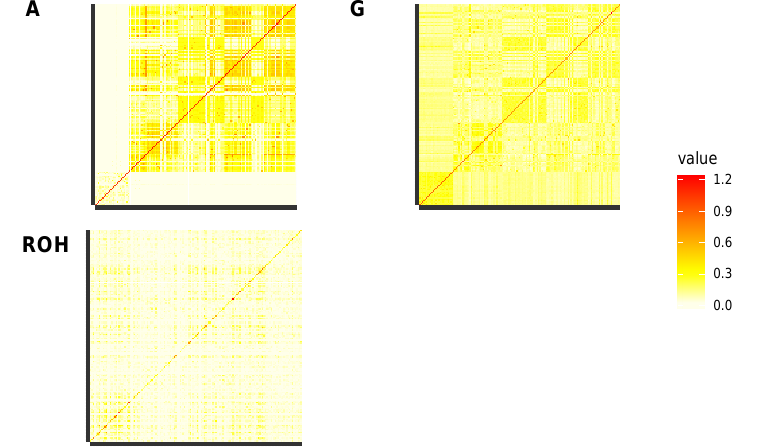
Figure 1. Matrix of genealogical ((A), top left ), single nucleotide polymorphisms (SNP)-based ((G), top right ) and regions of homozygosity (ROH)-based ( bottom left ) relationships between sampled individuals. Individuals are ordered by the farm they came from (Alberese,